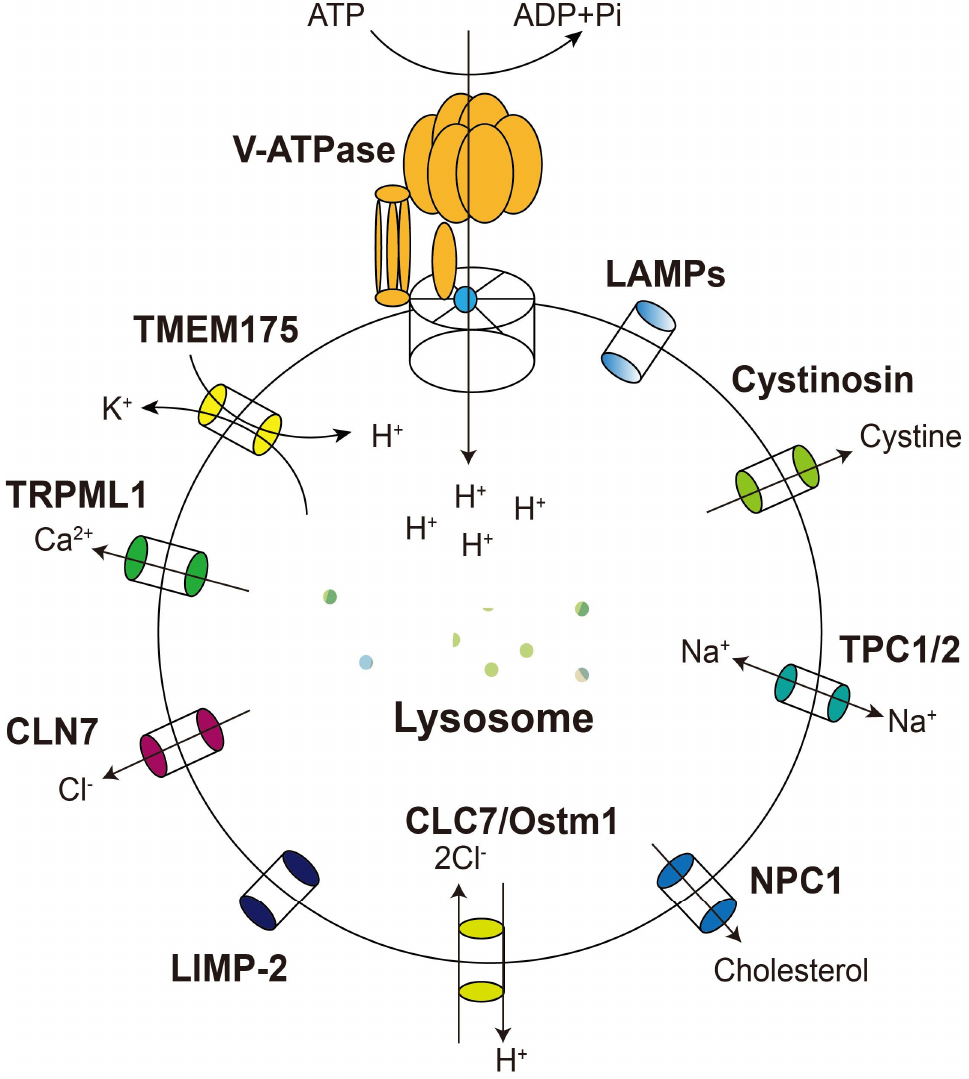
Figure 2. Lysosomal integral membrane proteins and their functions. The lysosomal integral membrane proteins discussed in this paper include LAMPs, LIMP ‐ 2, and various ion channels and transporters. LAMPs and LIMP ‐ 2 have been revealed to play a role in diseases such as cancer. The cation channels V–ATPase, TRPML1, TMEM175, and TPCs work together to regulate the concentrations of hydrogen, calcium, potassium, and sodium ions in lysosomes. The anion channels CLC7 and CLN7 are responsible for maintaining chloride ion balance. These ion channels help maintain the lysosomal membrane potential at − 40 and − 20 mV, which is necessary for lysosomes to perform their functions. The transporter proteins NPC1 and Cystinosin transport cholesterol and cystine,